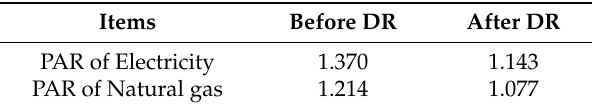
Table 3. PAR of loads before and after DR.